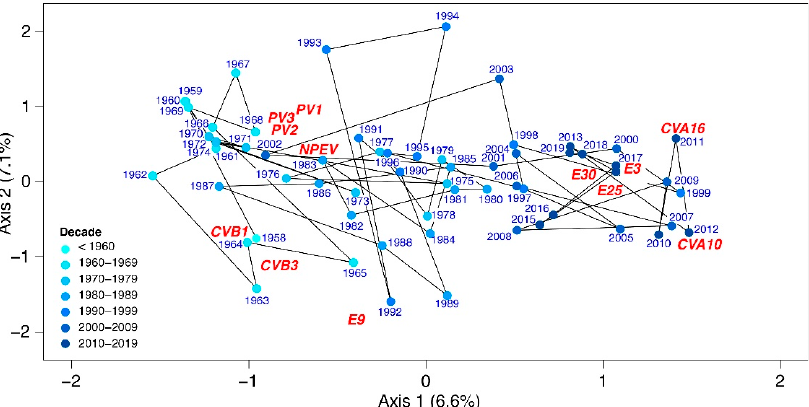
Figure 3. Canonical correspondence analysis (CCA) ordination plot showing temporal changes in the composition of enterovirus findings in the Slovak Republic from 1958 to 2020. Only the most frequent strains (top 50%) with the best fit (top 50%) to the temporal trend (first axis) are displayed. Ordination scores of these strains are shown in red letters (the position of the label matches the score position) and represent the space where the maxima of relative abundances are expected. Distances between sample scores (dots) represent the similarity of virus assemblage (polioviruses (PVs), coxsackieviruses (CV), and echoviruses (E)) composition among samples. The ordination plot is scaled symmetrically; variation explained by the ordination axes is displayed in parentheses. Note that the sample scores are distinguished by color in decadal steps and the axis values are standardized to zero-weighted means and unit-weighted variances.